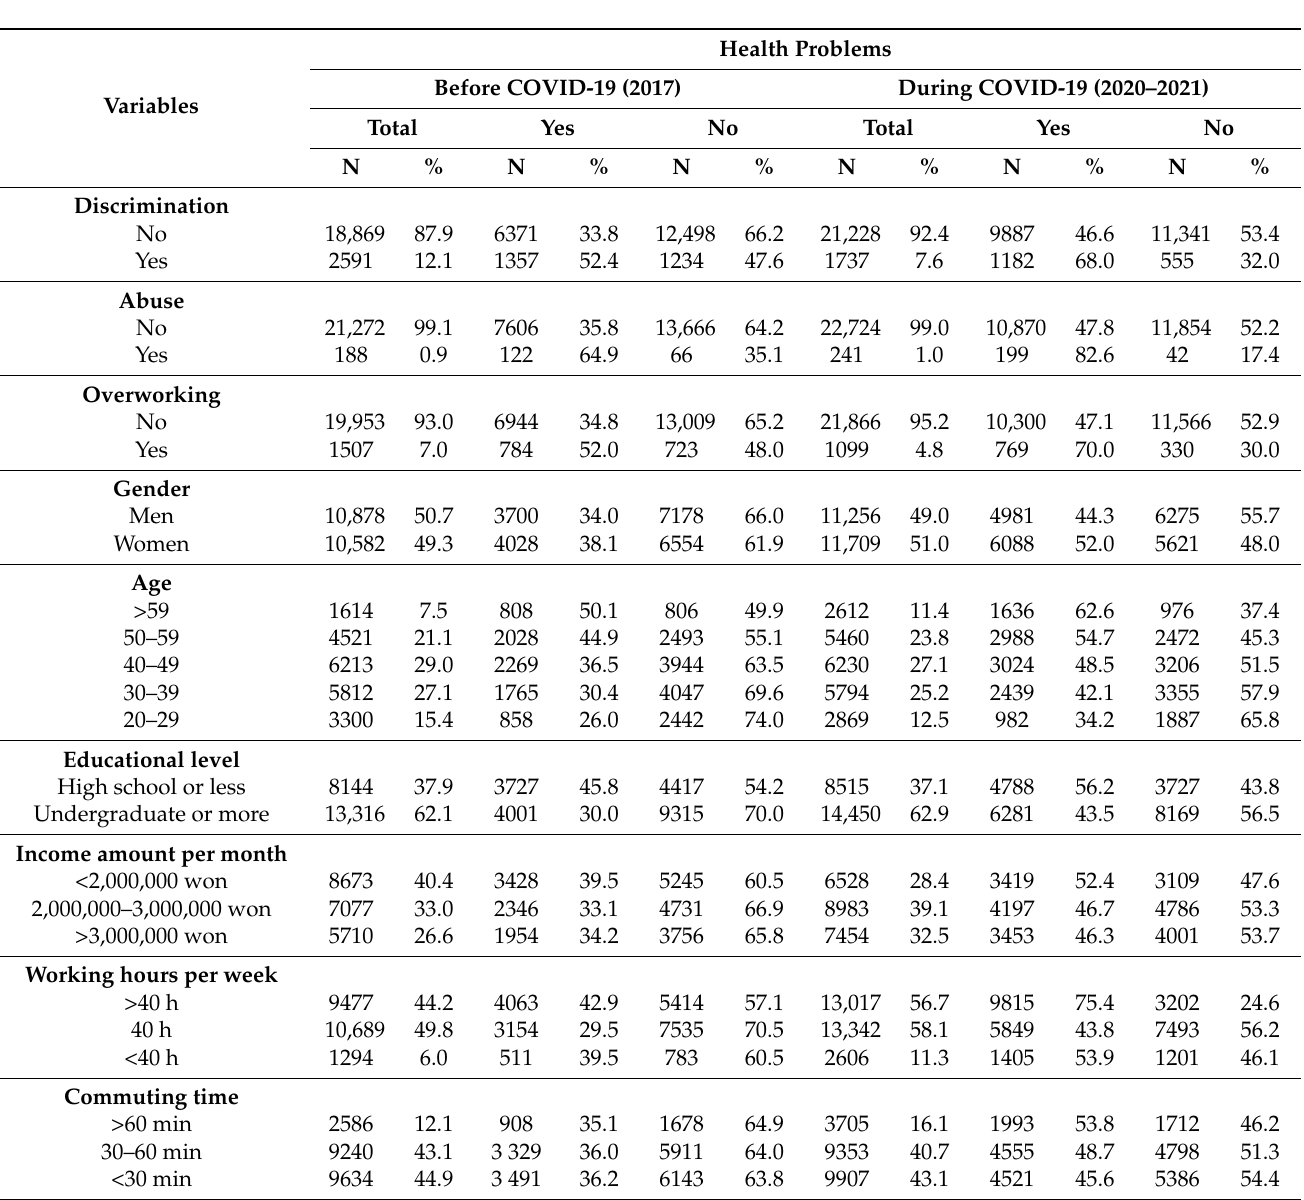
Table 2 illustrates the findings of the logistic regression analysis stratified by gender and the association between three types of workplace mistreatment and health symp- toms after adjustment to age, year, educational level, income amount/month, working hours/week, and commuting time. The detailed adjustment process for all models is depicted in Supplementary Table S1. These results suggested an association between all types of mistreatment and health problems among participants of both genders. The as- sociation was consistent throughout the models with such health symptoms as headache, eyestrains (“discrimination”: men (OR 2.40, 95% CI 2.16–2.67), women (OR 2.51, 95%